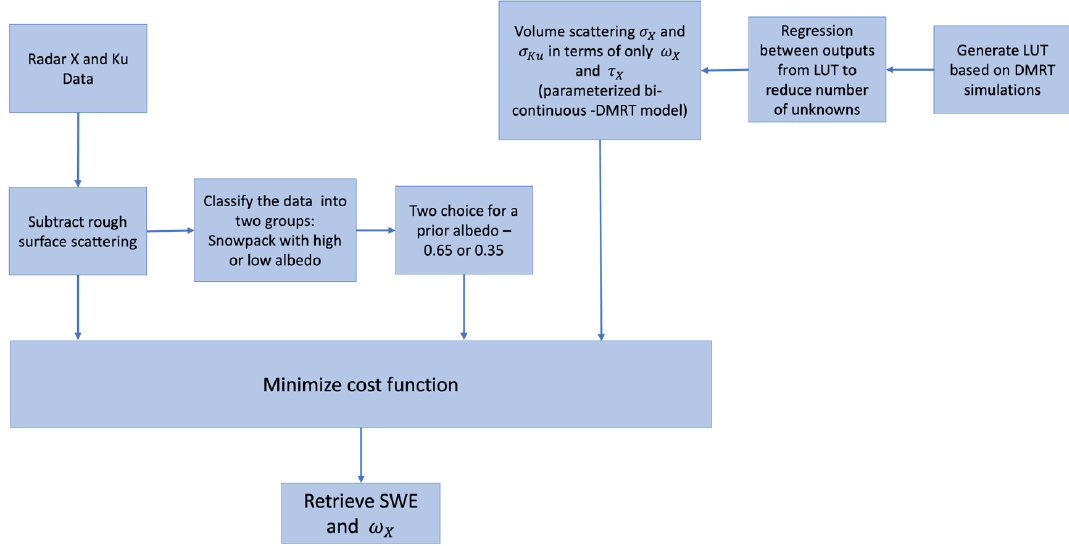
Figure 12. Simplified flow diagram of the algorithm. Two measurements to retrieve two parameters with a prior binary choice of albedo. No prior estimate of